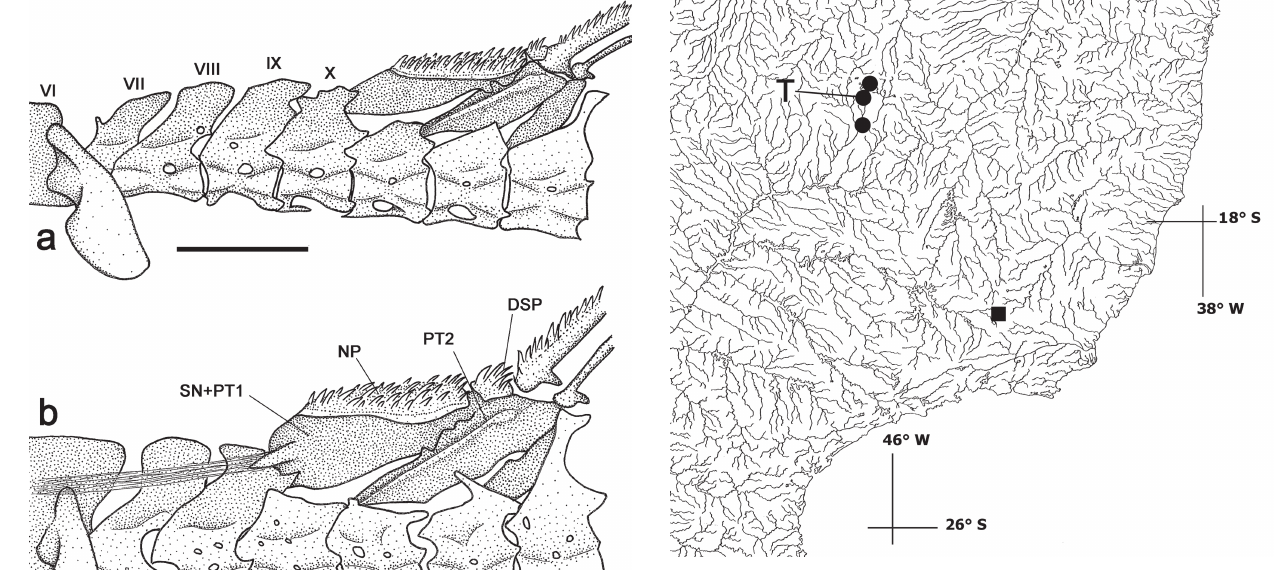
Fig. 4. Map of southeastern Brazil showing the distribution of Microlepidogaster longicolla (circles) and M . perforatus (square). T = type-locality. Each symbol may represent more than one